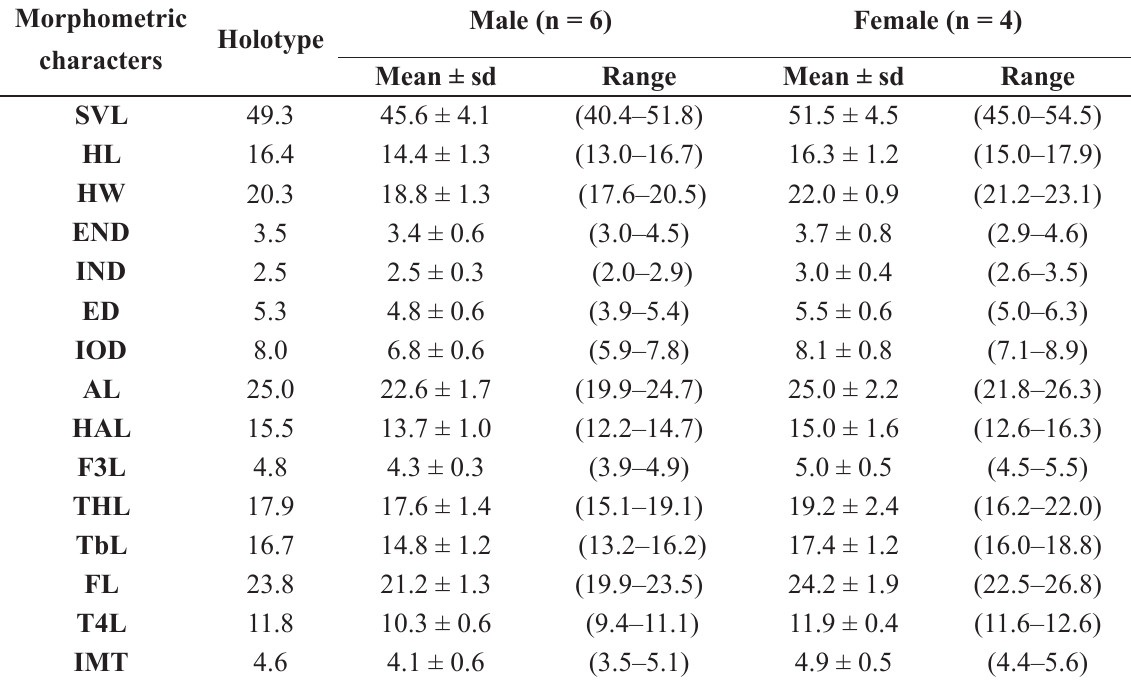
Table 1. Measurements (in mm) of the holotype and 10 paratypes of Odontophrynus toledoi sp. nov. The results are presented as the mean ± standard deviation (sd) and minimum–maximum values (range). Abbreviations of morphometric characters are defined in Material and